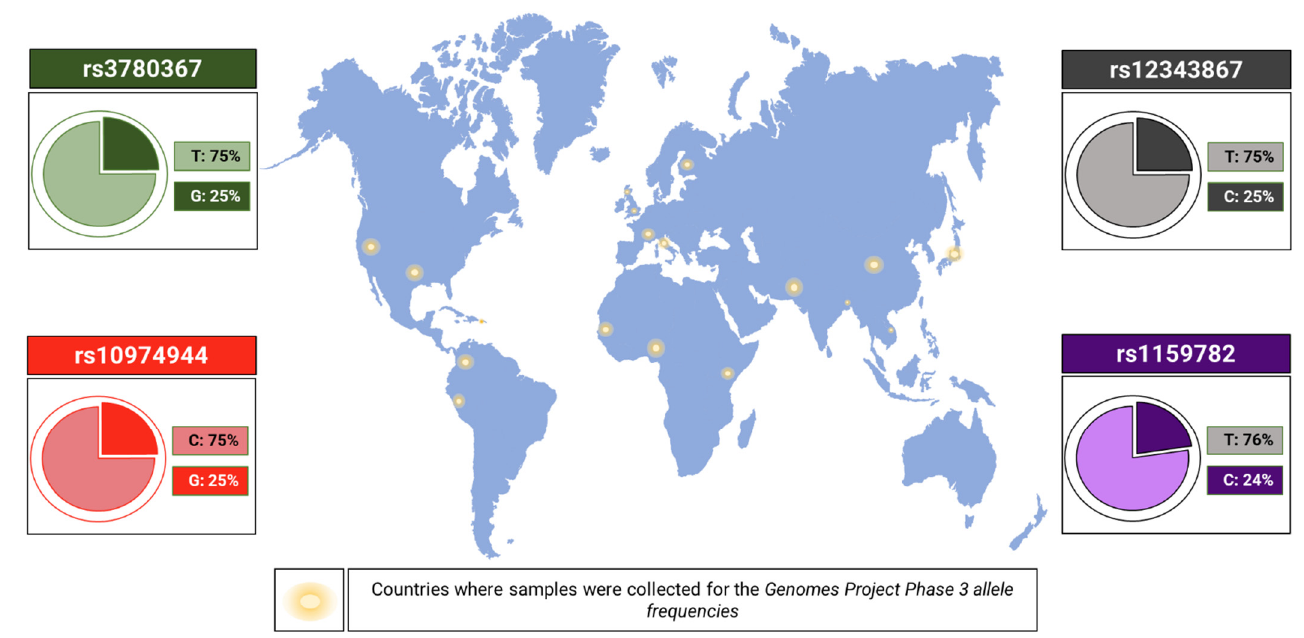
Figure 4. Minor allele frequency (MAF) of the 46/1 haplotype markers. Frequencies were measured from samples collected from individuals from Puerto Rico, Colombia, Peru, Gambia, Nigeria, Kenya, Italy, France, United Kingdom, Finland, Pakistan, India, China, Japan, and of Mexican origin residing in California and Texas (United States) [104–108] . The rs10119004 variant (NG_009904.1:g.:85805G>A; MAF of G: 38%), located close to